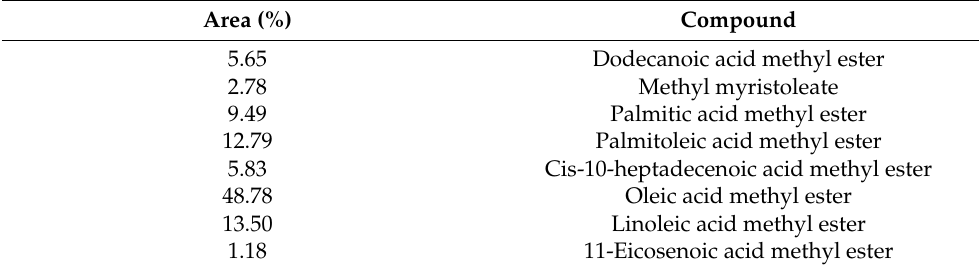
Table 5. Composition of the organic phase obtained after esterification of commercial oleic acid. Area